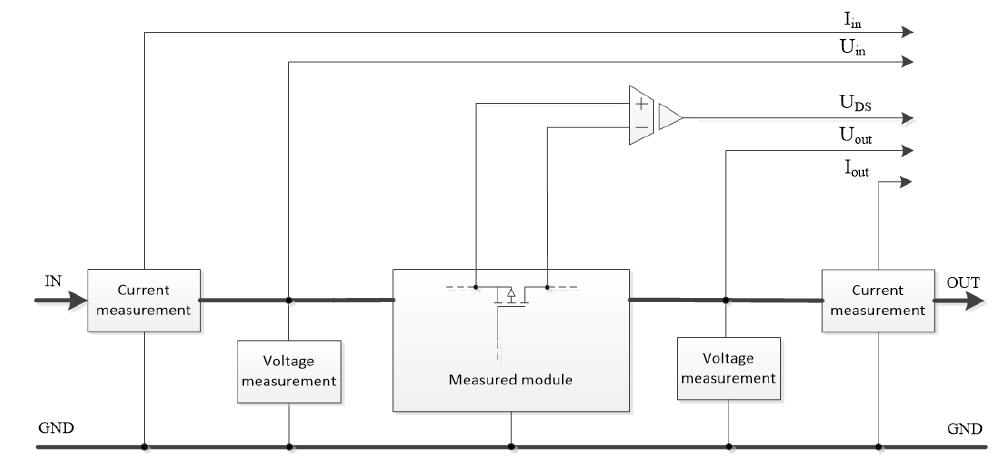
Figure 5. Module measurement